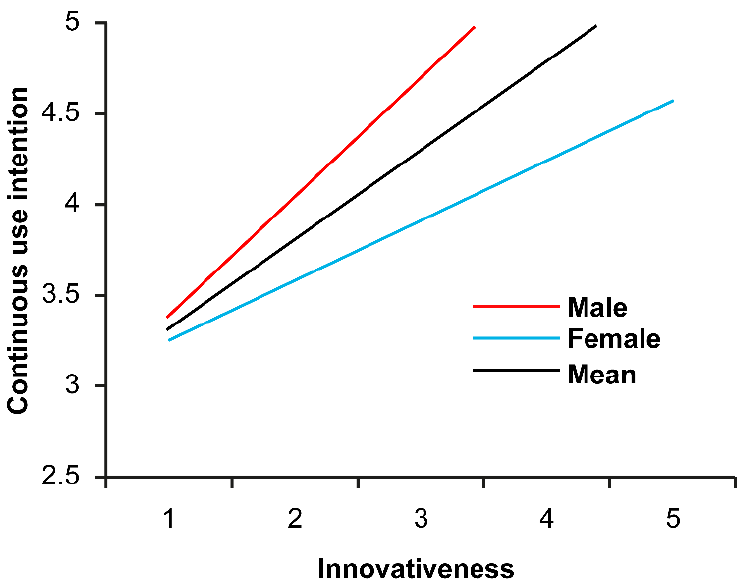
Figure 2. Result of a simple slope test using regression equation of innovativeness and gender.